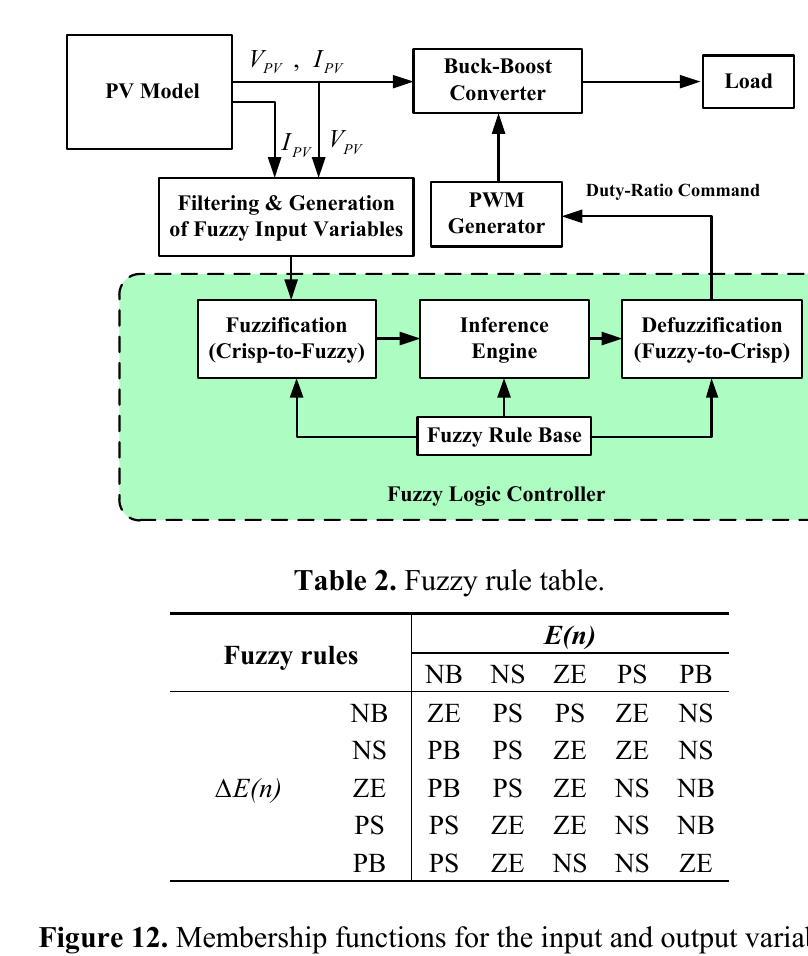
Figure 11. Fuzzy logic controller for the MPPT design.